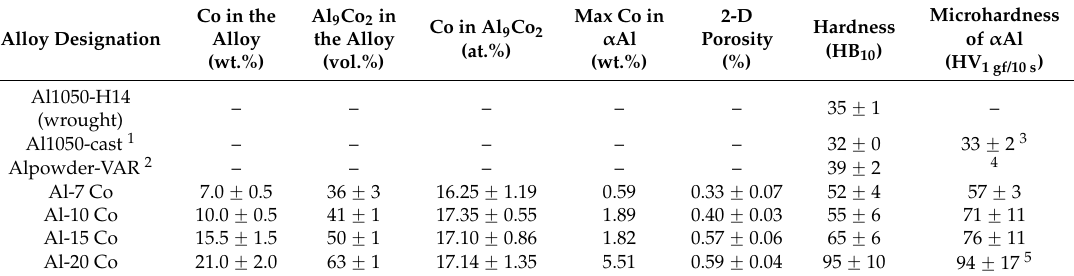
Table 2. Compositional, porosity and hardness data of the alloys,